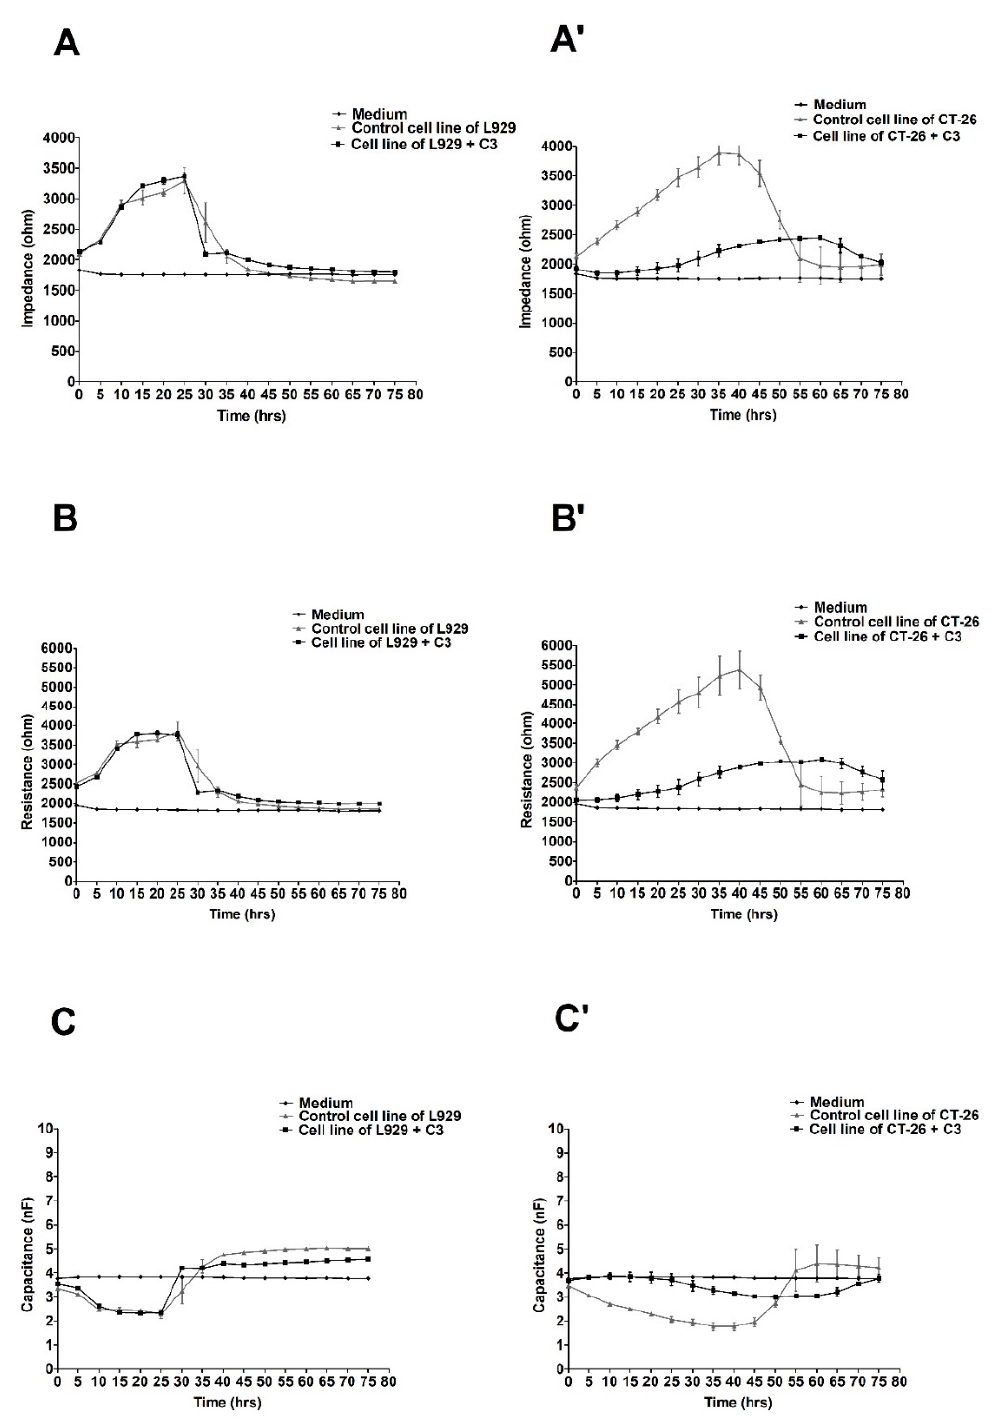
Figure 3. Impedance, resistance, and capacitance monitoring of the cell lines L929 ( A – C ) and CT-26 ( A’ – C’ ) during 80 h treatment with ex-LMS in concentration C3. The graphs show the course of impedance changes in L929 ( A ) and CT-26 ( A’ ) cultures after treatment with ex-LMS at a concentration of C3 (228.5 µ g/mL); resistance changes in L929 ( B ) and CT-26 ( B’ ) cultures after treatment with ex-LMS at a concentration of C3 (228.5 µ g/mL); and capacitance changes in L929 ( C ) and CT-26 ( C’ ) cultures after treatment with ex-LMS at a concentration of C3 (228.5 µ g/mL). Data are presented as mean value ± SEM.